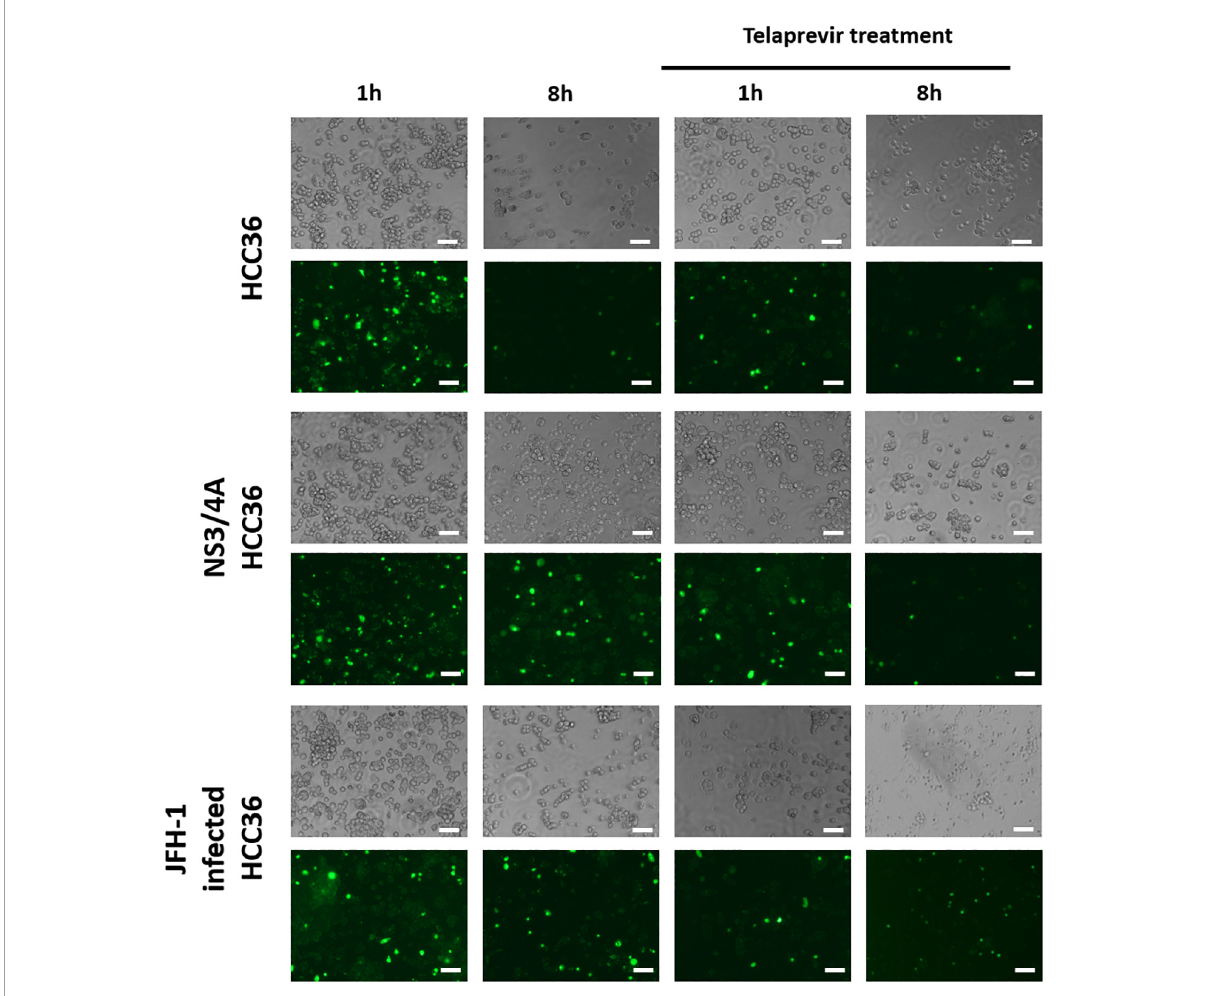
FIGURE2 Specific retention of TAT- (cid:49) NS3/4A-FITC in NS3/4A-HCC36- and HCV-infected cells. HCC36 cells, NS3/4A-HCC36 cells, or JFH-1-infected HCC36 cells were incubated with 10 µ M TAT- (cid:49) NS3/4A-FITC in the absence or presence of 2 µ M telaprevir (NS3/4A protease inhibitor) at 37 ◦ C for 1 h. The cells were washed with DMEM containing 10% serum three times per hour. After culturing for 1 or 8 h, the phase contrast and fluorescence of viable cells were observed under a fluorescence microscope. Scale bar: 100 µ